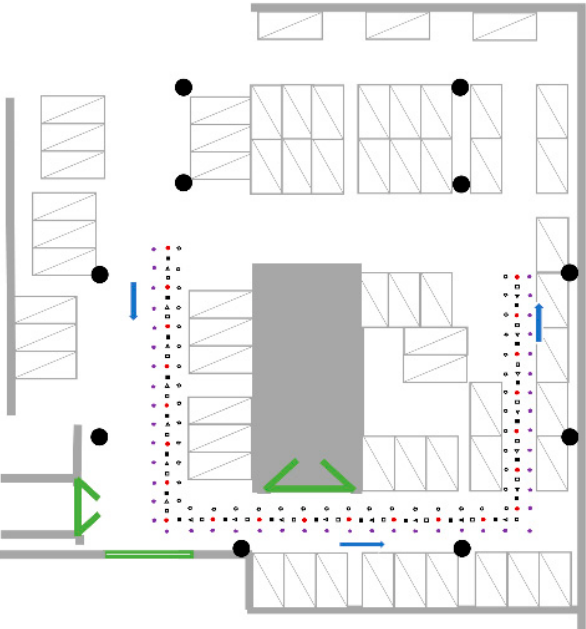
Figure 4. Schematic diagram of Park environment.